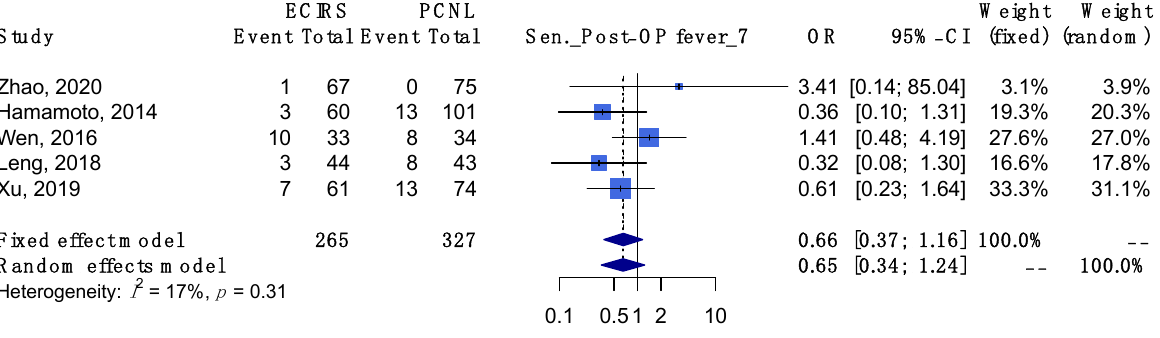
Figure A23. Sensitivity analysis of outcome regarding post-operative fever. ([17–19,22,23])